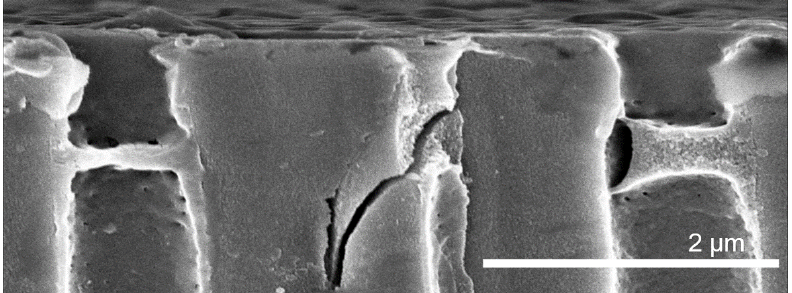
Figure 3. FESEM imaging of porous silicon support cross-section with three bilayers PDADMAC/PSS with air-filled support during polyelectrolyte complexation. Left pore: prominent axial shrinking of polyelectrolytes, right pore: prominent radial shrinking of polyelectrolytes due to